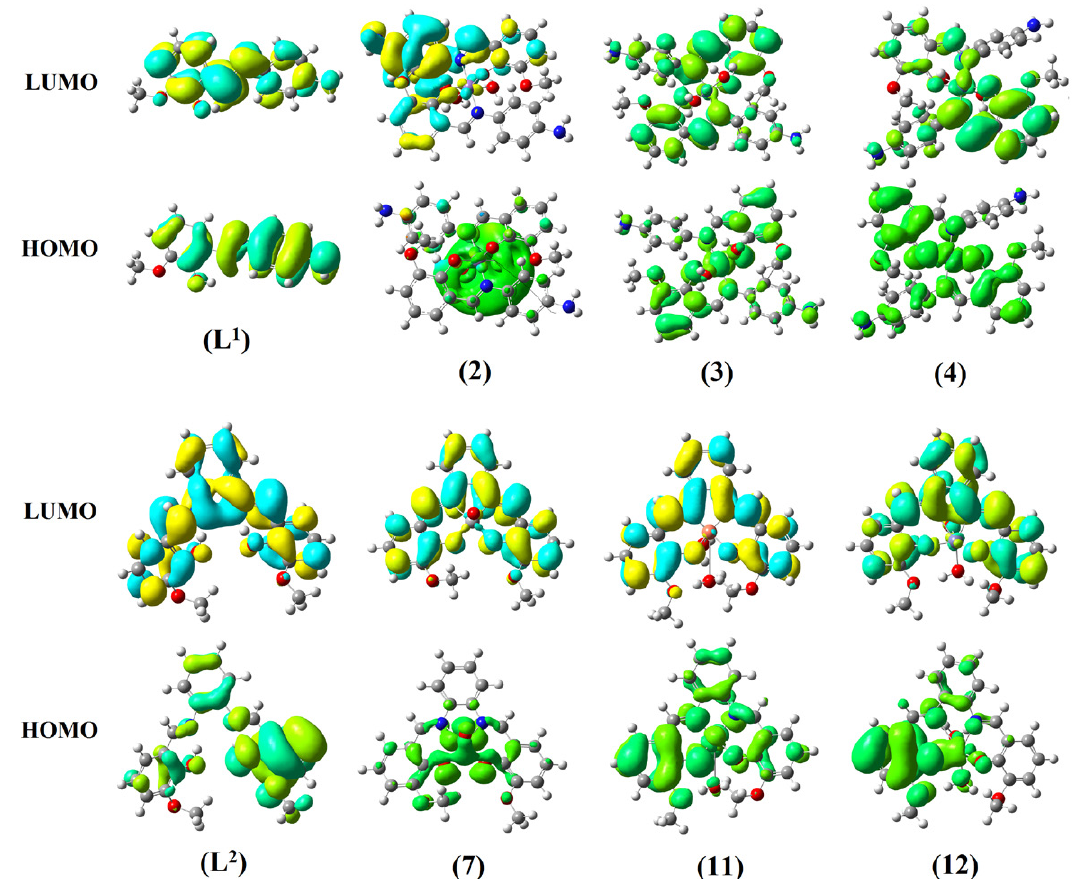
Figure 3. Frontier molecular orbitals (FMOs’) illustrating distribution of electronic charge density in ligands and their selected metal